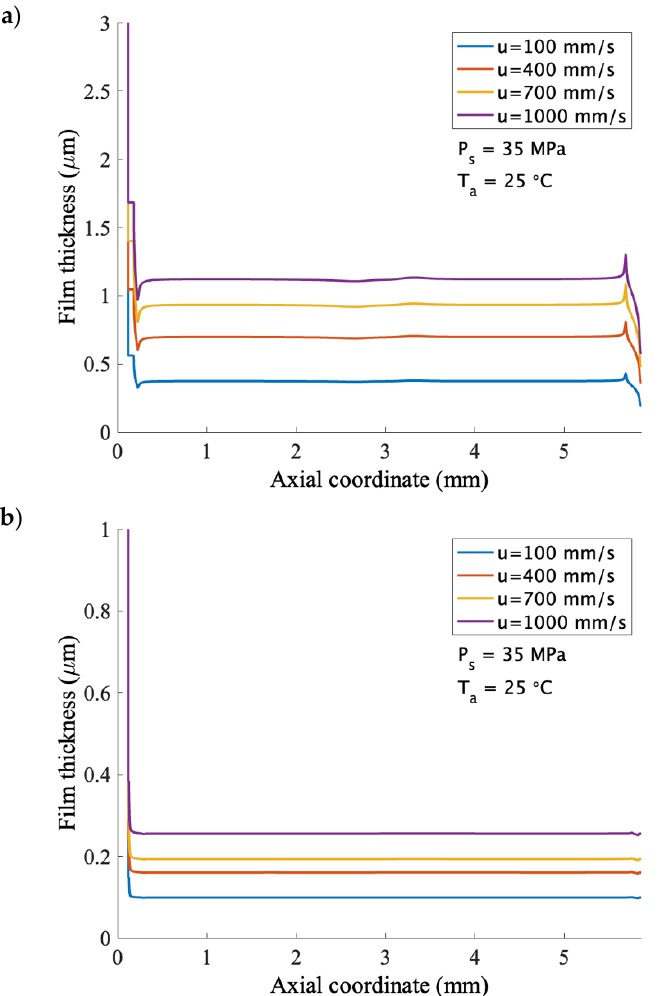
Figure 5. Film thickness distribution at different rod velocities (mm/s), 35 MPa, and 25 ℃ : ( a ) out- stroke and ( b ) instroke.